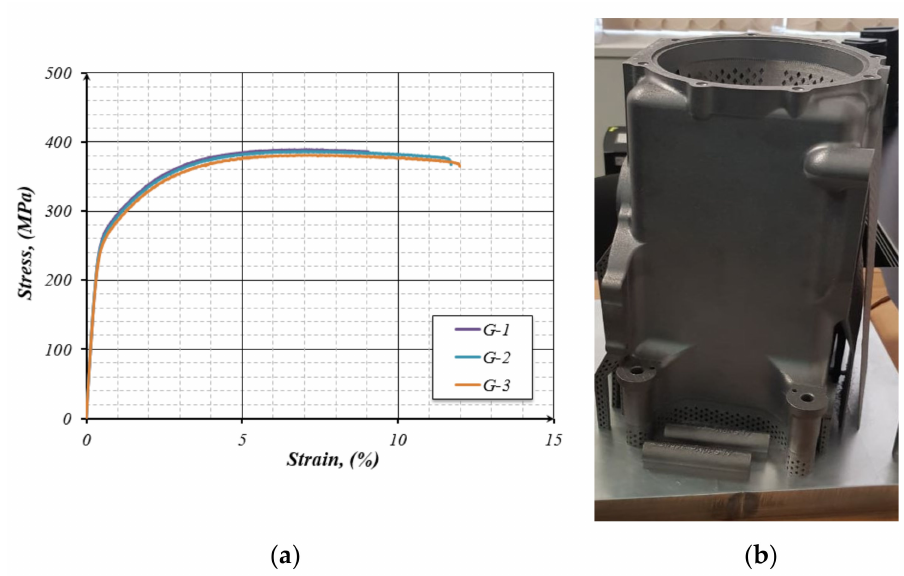
Figure 11. The strain-stress curves of three synthesized samples from the AlSi10Mg alloy ( a ); proto- type of a GTE gearbox housing, made from AlSi10Mg alloy powder ( b